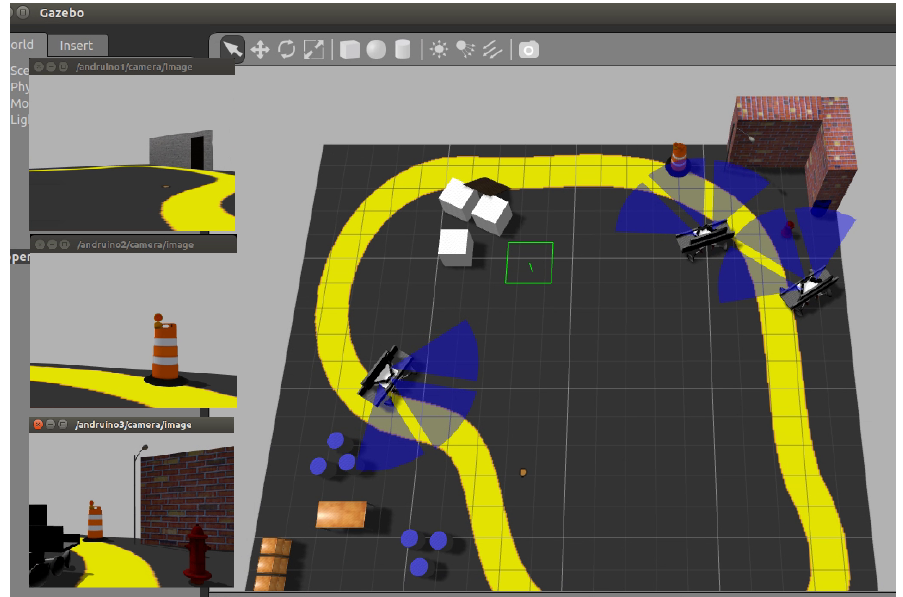
Figure 6. Andruino-R2 multi-robot simulation in